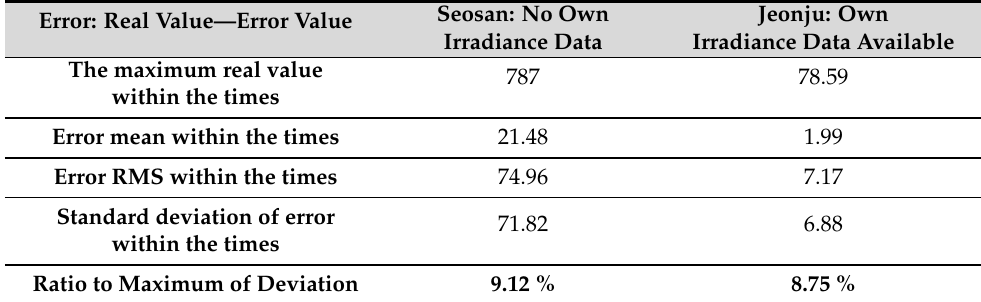
Table 7. Evaluation index value which is prediction model performance with test